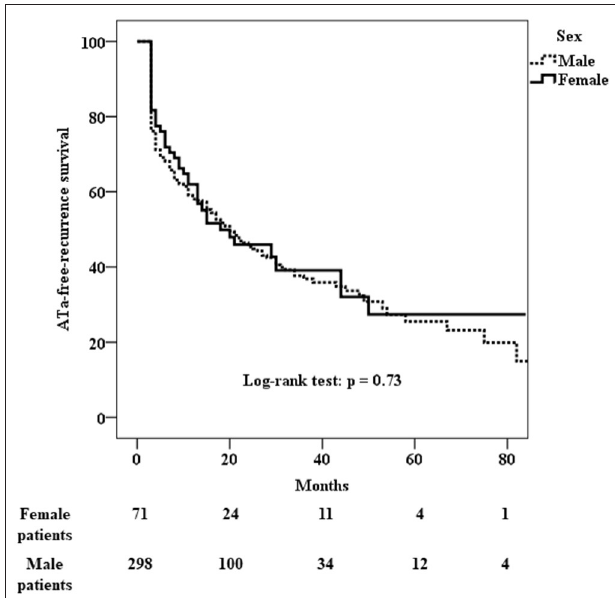
FIGURE 3 | Kaplan-Meier analysis of cumulative survival for ATa recurrence after cryo-PVI for non-paroxysmal AF. There was no sex difference in the risk of recurrence ( p = 0.73).